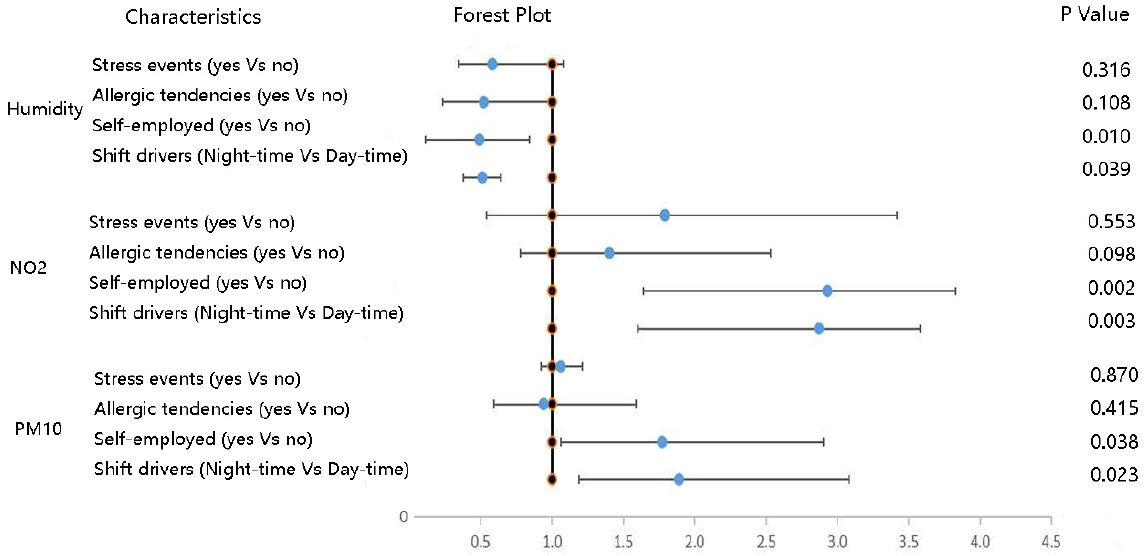
Figure 3. The forest diagram of adjusted odds ratio of PM 10 (26 μ g/m 3 increase), NO 2 (10 μ g/m 3 increase) or humidity (15% increase) on dry eye disease, stratified by significant covariates. Adjustment for all the potential covariates in Table 2 included characteristics of taxi drivers except for the stratification variables.